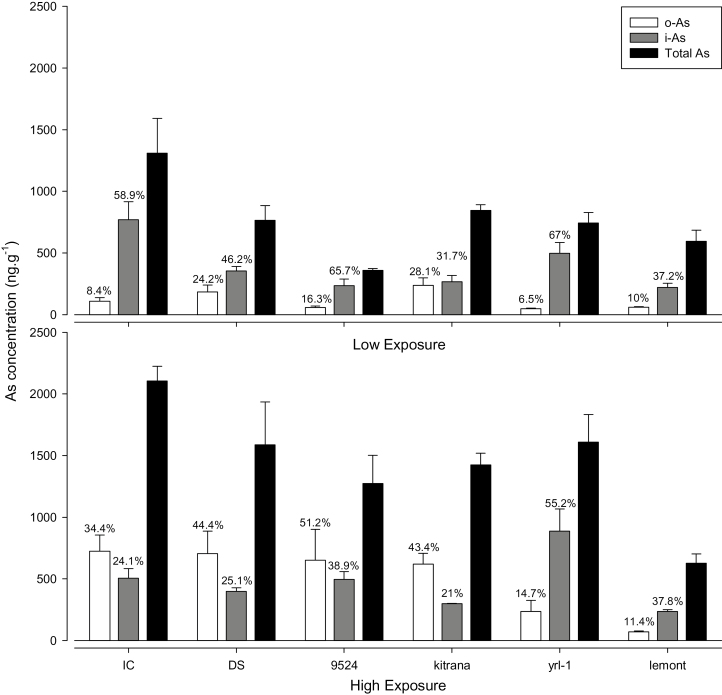
Total As concentration, inorganic As (i-As), and organic As (MMA+DMA, o-As) in grains of rice cultivars exposed at low (L) and high (H) As levels (dry weight). The percentage of o-As and i-As in relation to total arsenic (not sum of species) is above the bars.